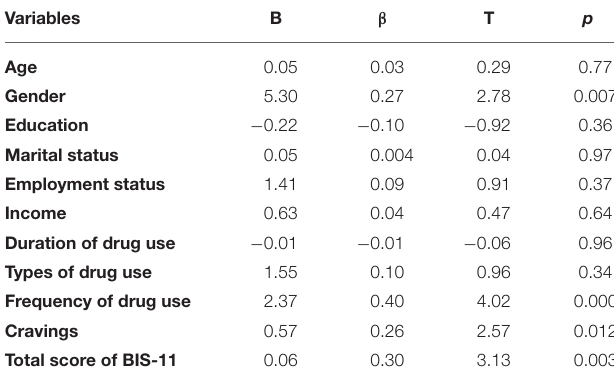
TABLE 4 | Multiple linear regression of all the variables in this